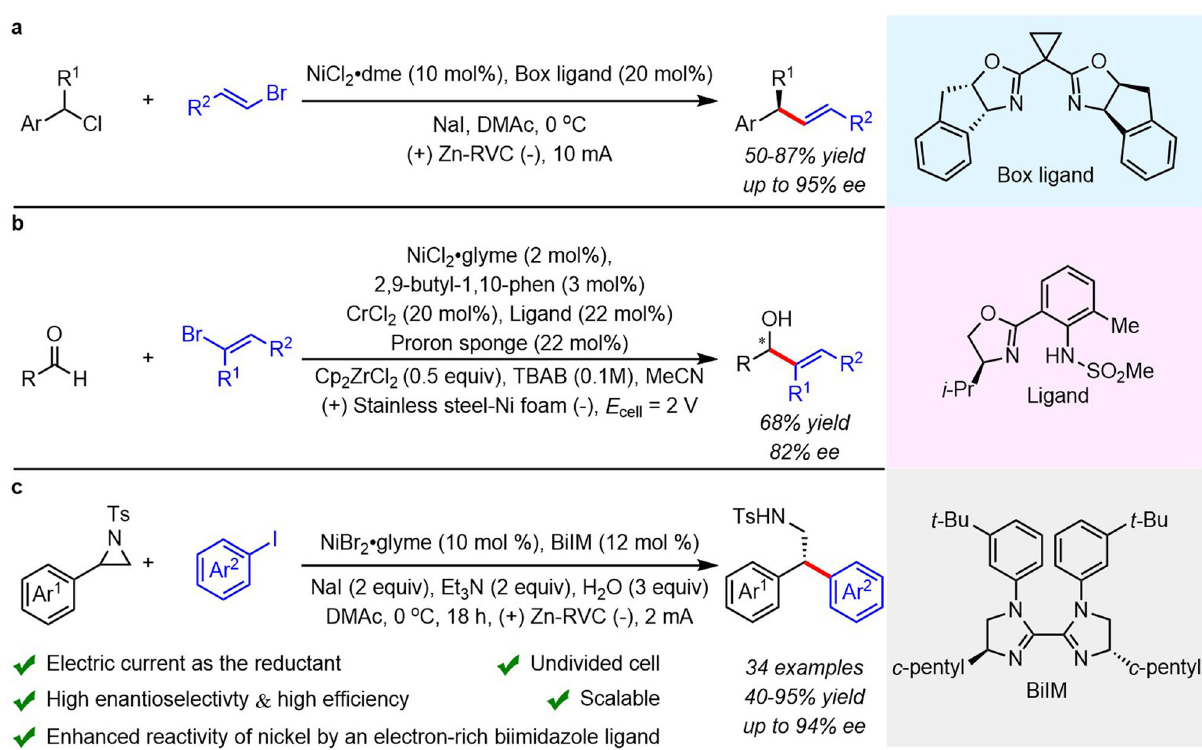
Fig. 1 | Enantioselective electrochemical reductive cross-couplings. a Pioneering work on enantioselective electrochemical reductive cross-couplings by Reisman. b Enantioselective electrochemical NHK coupling by Reisman,